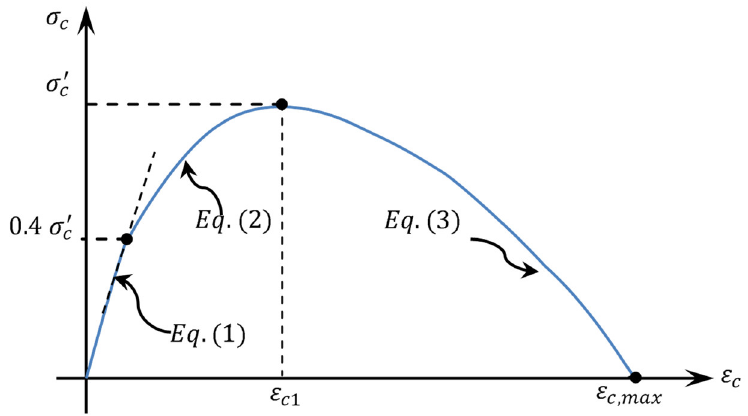
Figure 4. The   –   curve of concrete under compressive